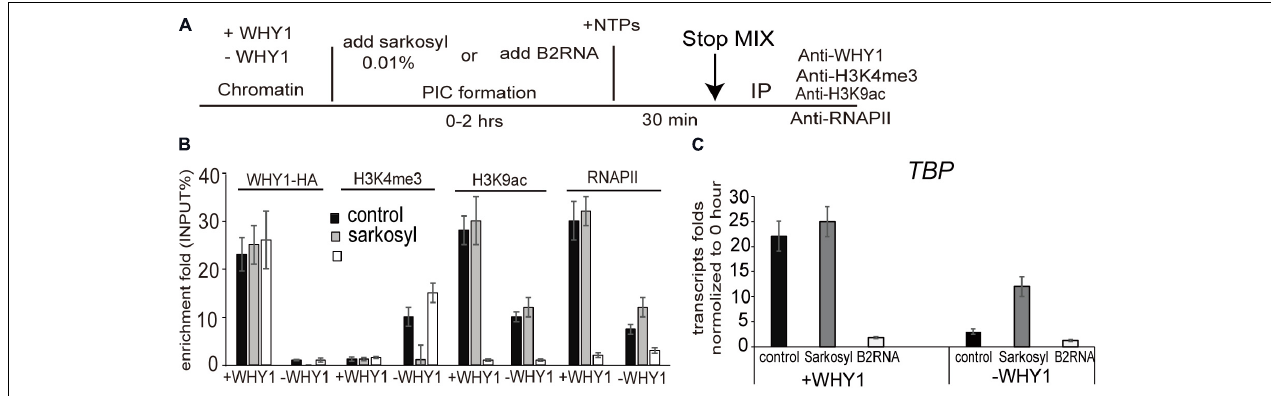
FIGURE 5 | WHIRLY1 affects H3K4me3 and H3K9ac at the preinitiation conformation stage. (A) Schematic of the in vitro transcription assay. (B) ChIP experiments were performed on chromatin assembled in vitro after transcription in presence or absence of 0.01% sarkosyl or 800 nM B2RNA with indicated antibodies. H3K4me3 and H3K9ac levels were relative to H3 levels. Three biological replicates and three technique replicates were used to analyze. Error bars represent SE. (C) The report gene transcription level by qRT-PCR. Three biological replicates and three technique replicates were used to analyze. Error bars represent SE.